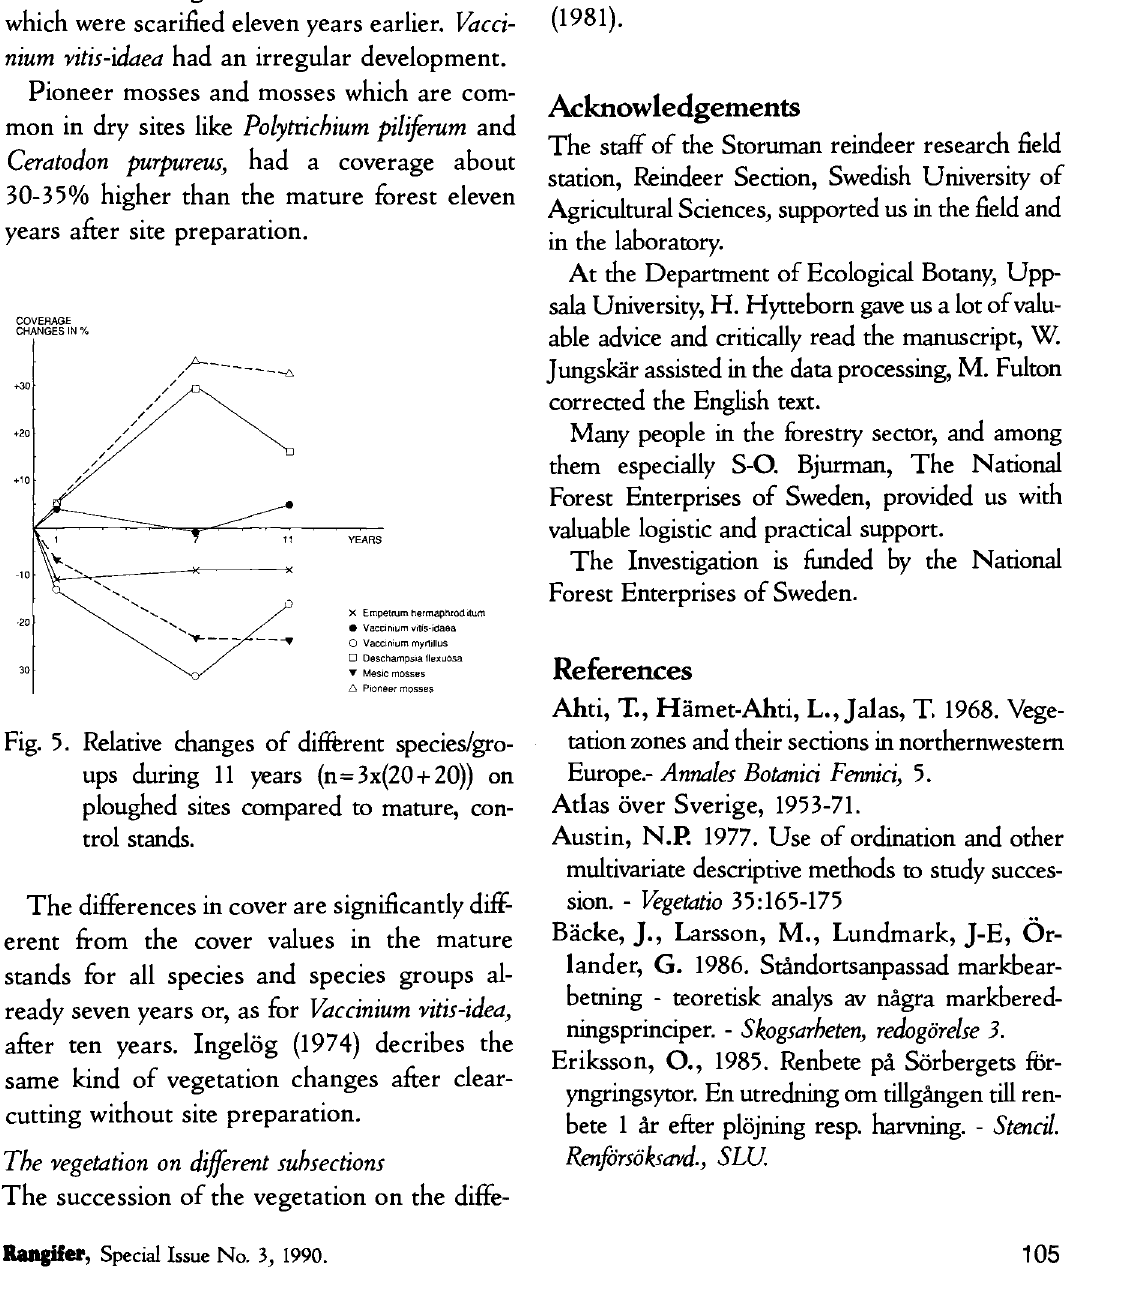
Fig. 5. Relative changes of different species/gro ups during 11 years (n=3x(20 + 20)) on ploughed sites compared to mature, con trol